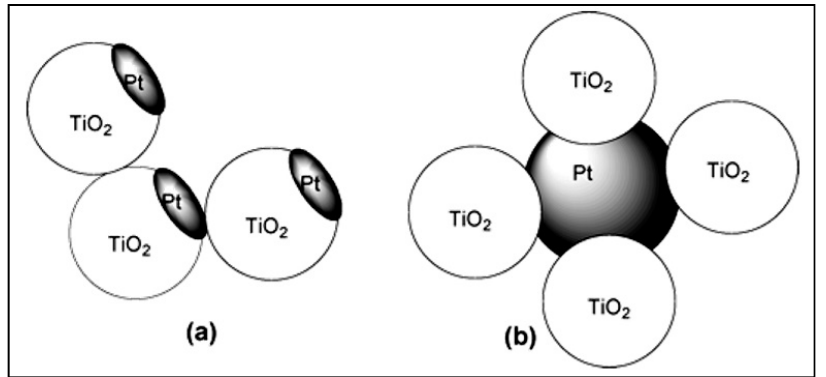
Figure 13. Models of Pt-TiO 2 formed by ( a ) photodeposition of Pt, and ( b ) physical mixing of colloidal Pt and TiO 2 . Reprinted with permission from reference [222]. Copyright 2004 American Chemical Society.